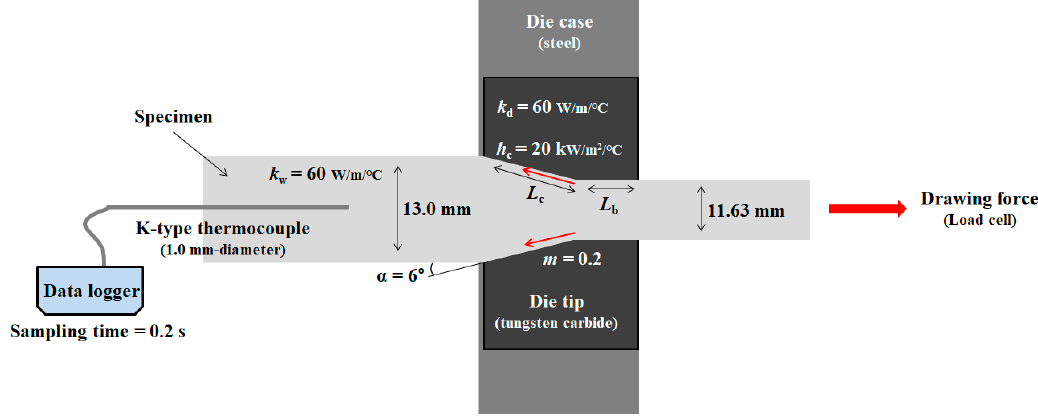
Figure 3. Schematic illustration of wire drawing process performed in this study.